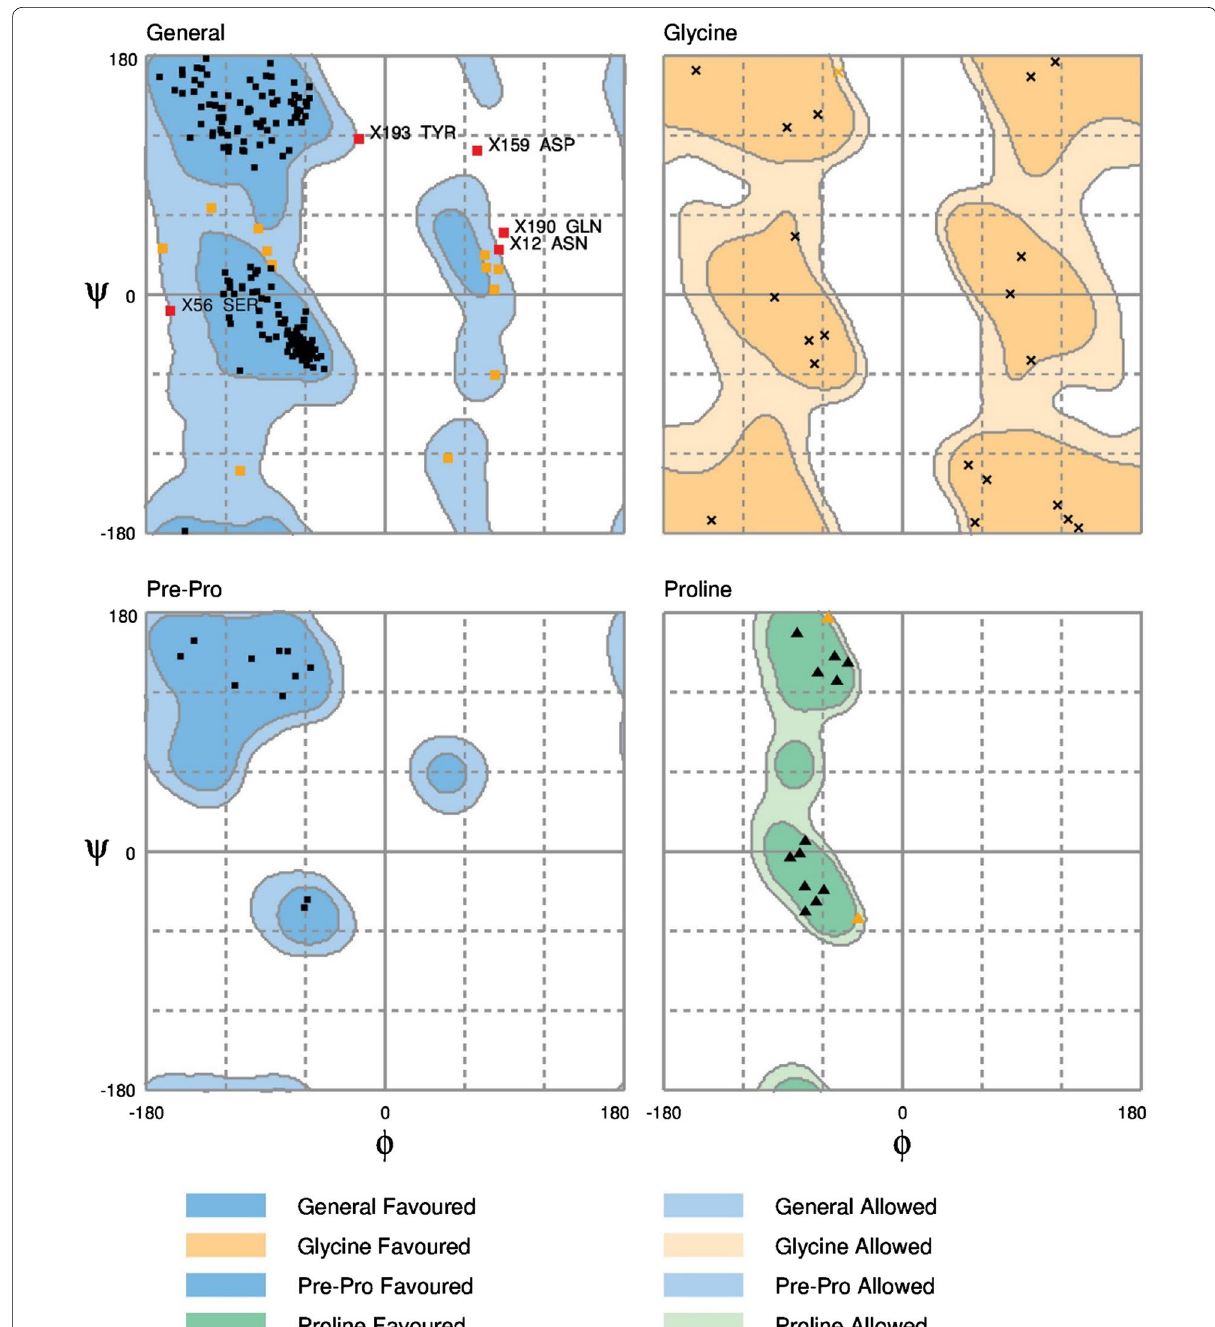
Fig. 2 The Ramachandran’s plot of the STE/STE20/YSK protein kinase model computed with the RAMPAGE